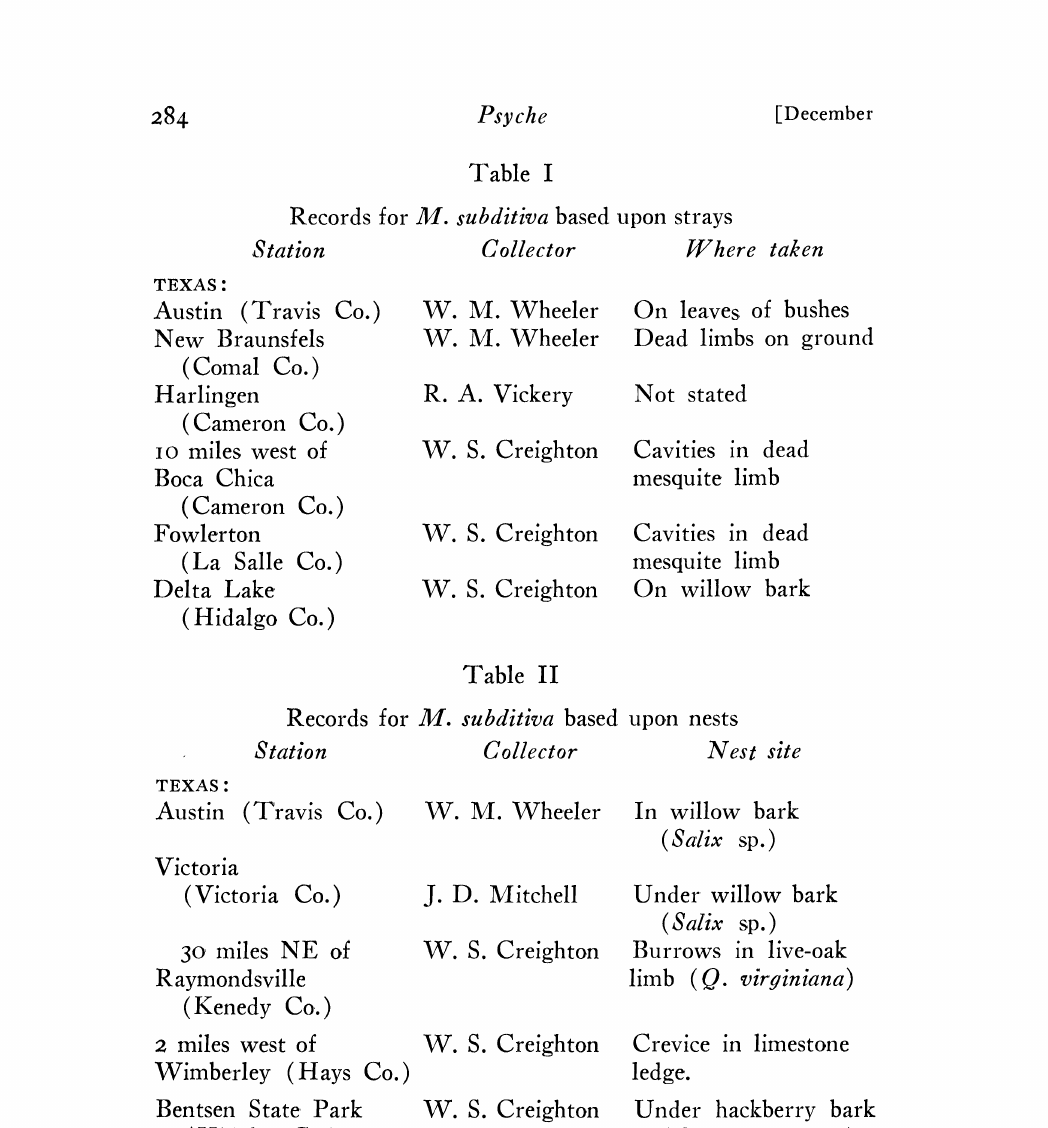
Records for M. subditiva based upon nests